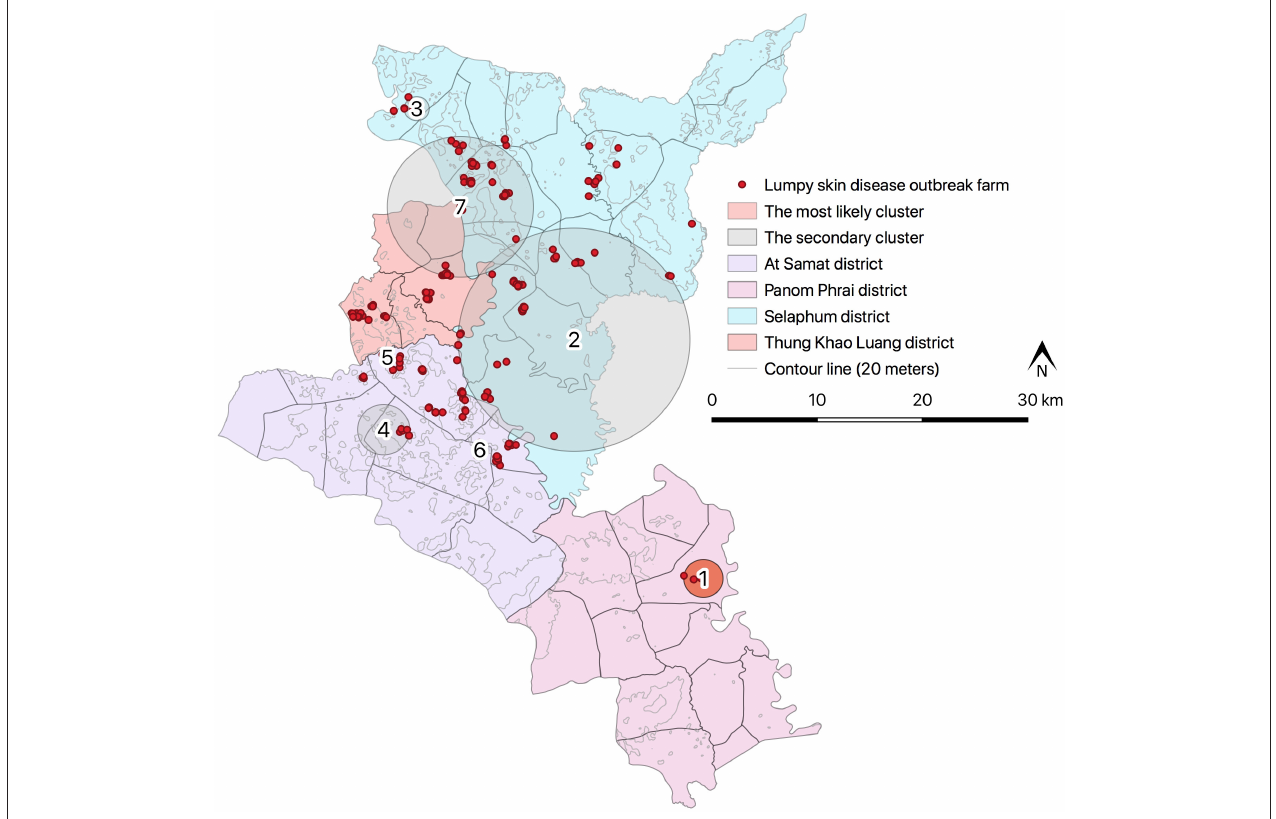
FIGURE 4 | Spatio-temporal clusters of lumpy skin disease identified by space-time permutation model.